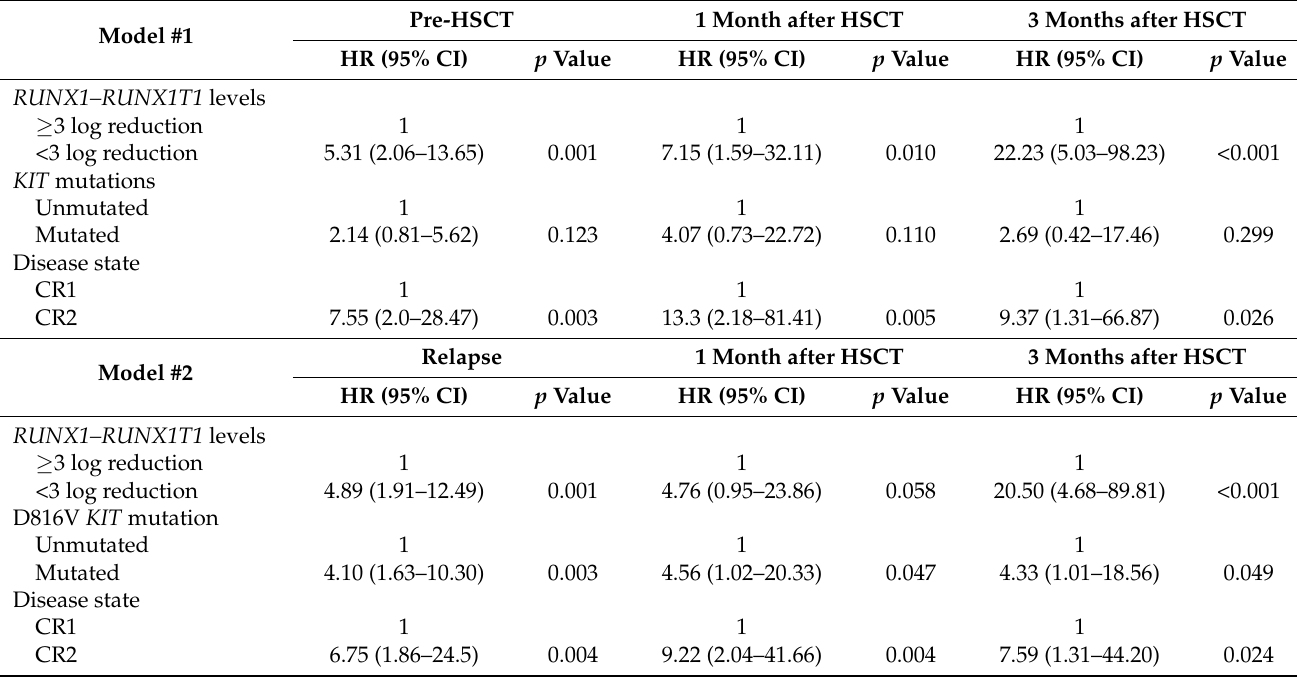
Table 3. Multivariate analyses to evaluate the prognostic independency of D816V KIT mutation and RUNX1–RUNX1T1 MRD status at each time point for predicting post-transplant relapse.